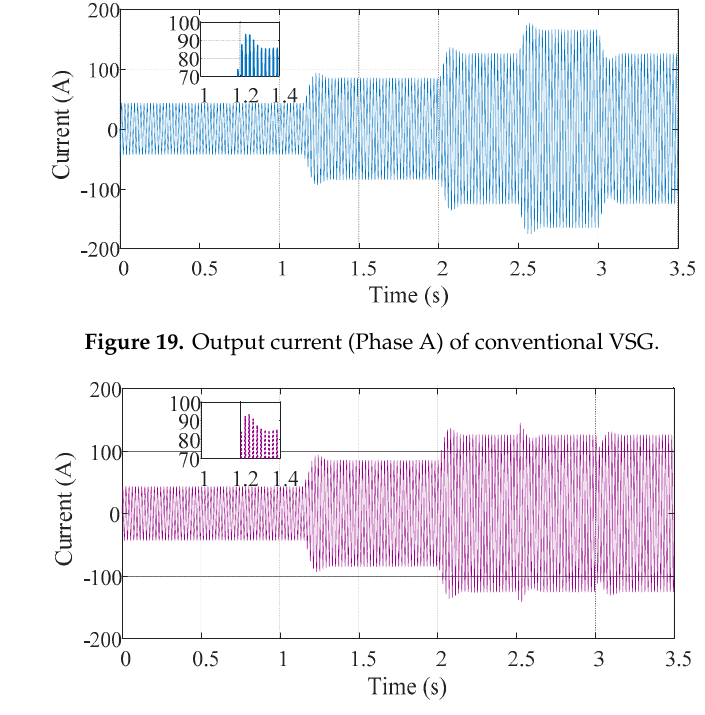
Figure 20. Output current (Phase A) of PLL-VSG.